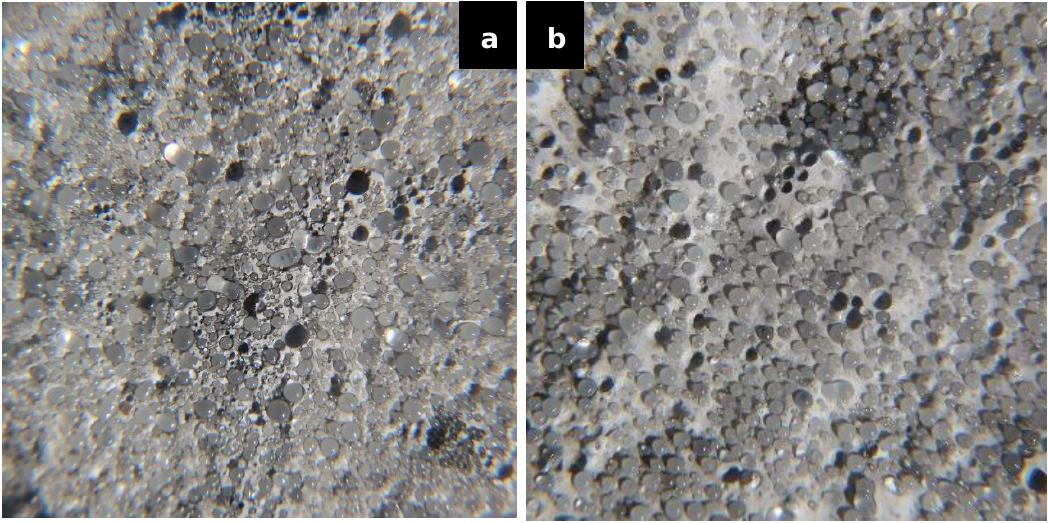
Figure 8. In situ surface detail after 1 month of service: ( a ) S2 sample; ( b ) S4 sample.